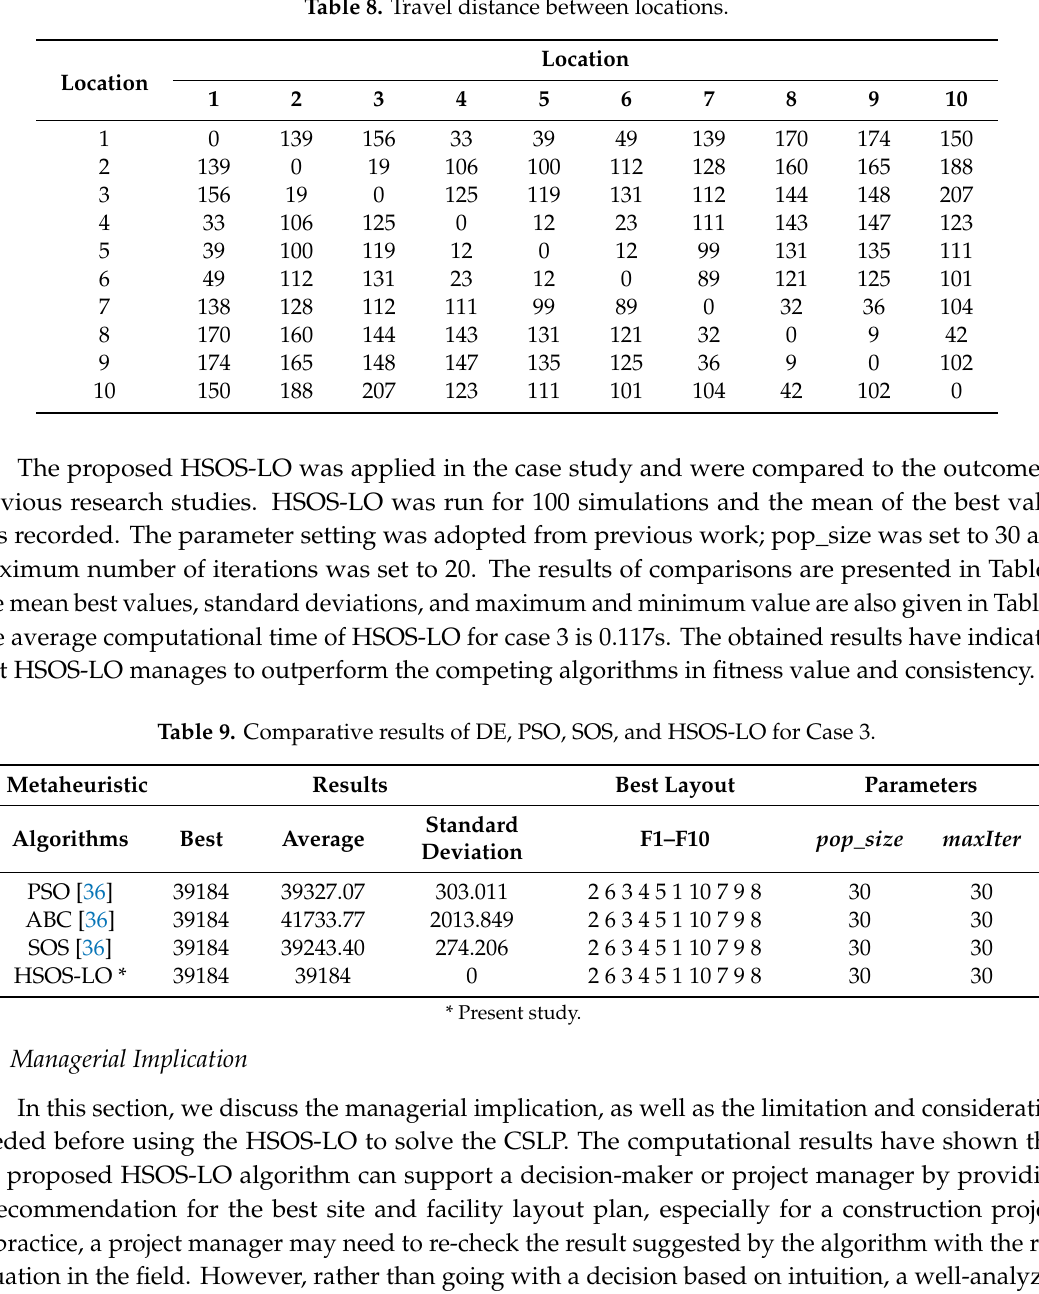
Table 8. Travel distance between locations.